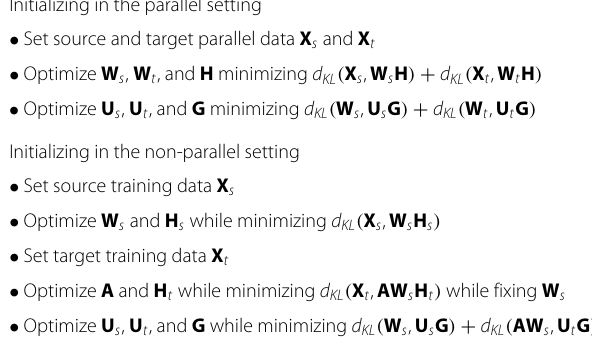
Table 1 Algorithm for initializing parameters Initializing in the parallel